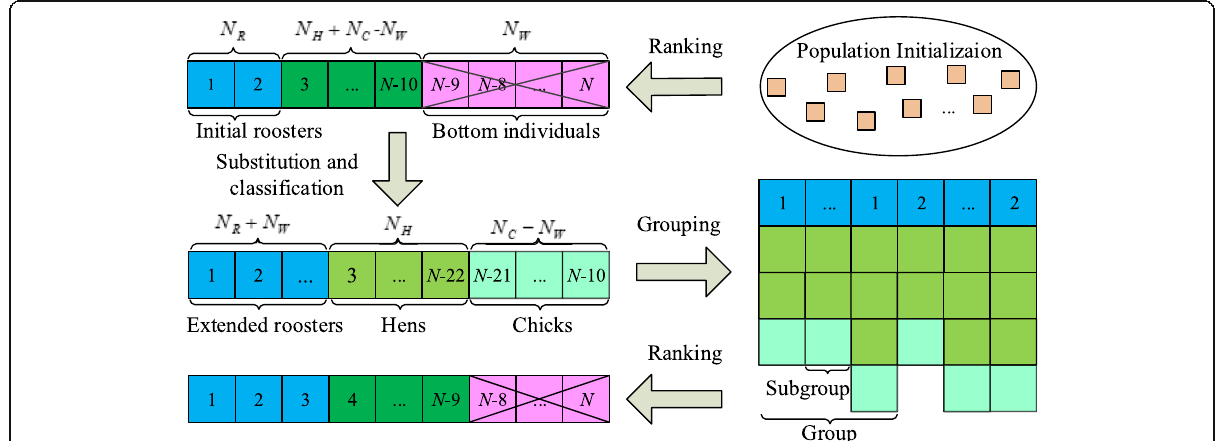
Fig. 1 Framework of SIB strategy. Describes the mechanism and process of the substitution of bottom individual (SBI) strategy. After the operation of initialization and ranking, the initial rooster and bottom individuals are selected. Substitution and classification are then implemented to redefine the hierarchy of the population. Afterward, subgroup can be obtained by grouping